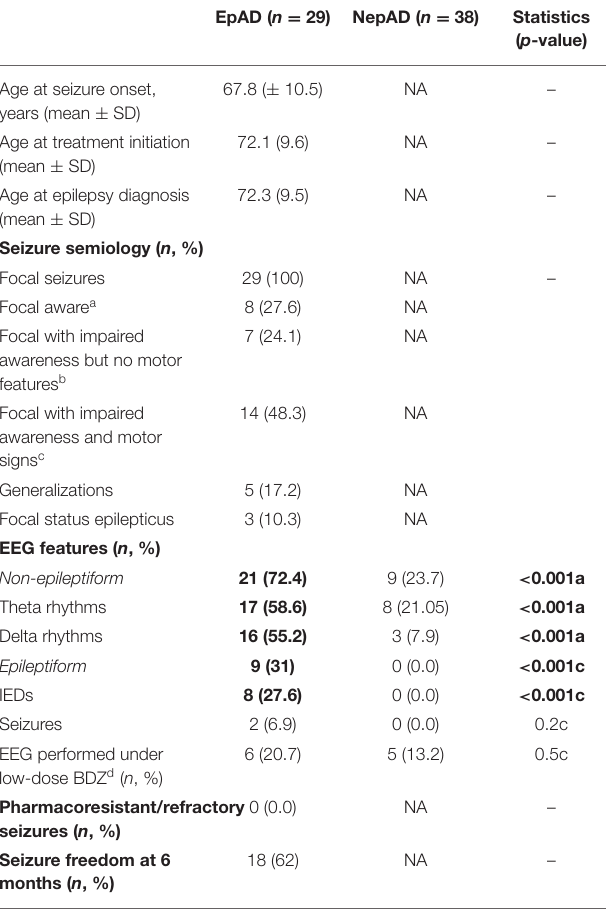
TABLE 3 | Epileptological